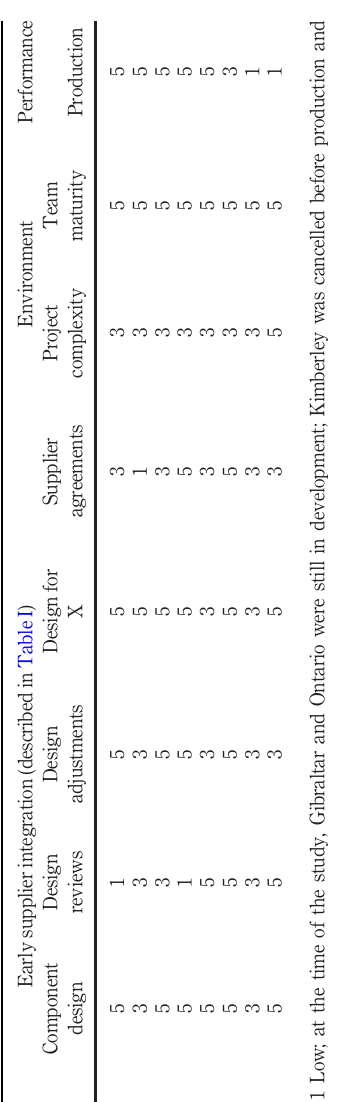
Table IV. Supplier involvement levels, environment and production